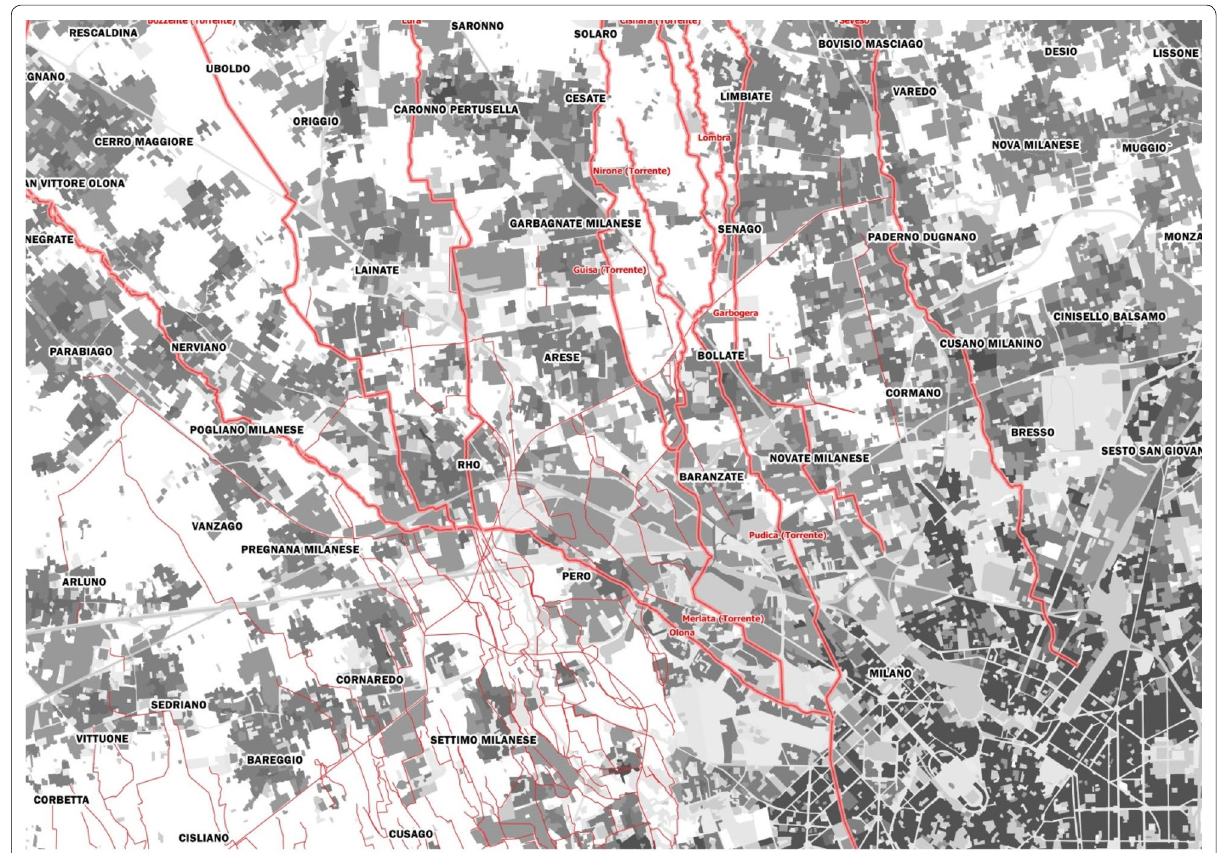
Fig. 2 Rivers networks in the Milan North-West urban area (Source: Geoportale Regione Lombardia/elaboration of the